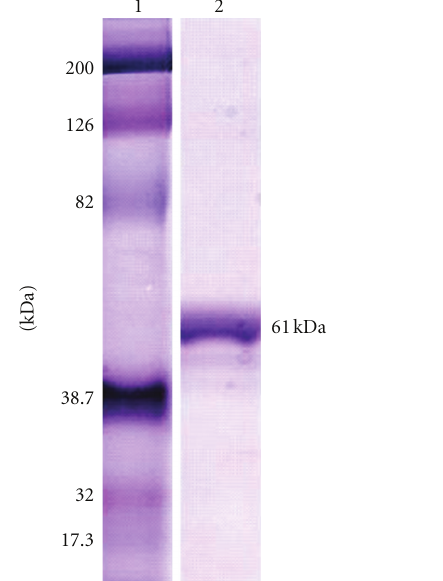
Figure 2: SDS-PAGE of CeSP. Gel 12%. Lane 1: molecular mass markers: myosin (200kDa), β -galactosidase (126kDa), bovine alb- umin (82.0kDa), carbonic anhydrase (38.7kDa), soybean trypsin inhibitor (32.0kDa), and lysozyme (17.3kDa). Lane 2: purified CeSP (50 μ g), under reducing conditions.